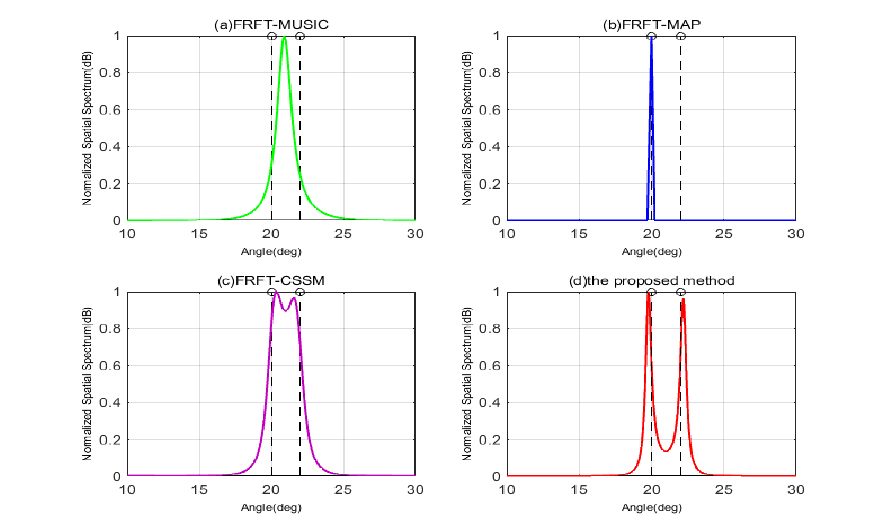
Figure 5. The normalized MUSIC spatial spectrums by four different algorithms with SNR = 10 dB, ∆ θ = 2 ◦ . ( a ) FRFT-MUSIC; ( b ) FRFT-MAP; ( c ) FRFT-CSSM; ( d ) The proposed